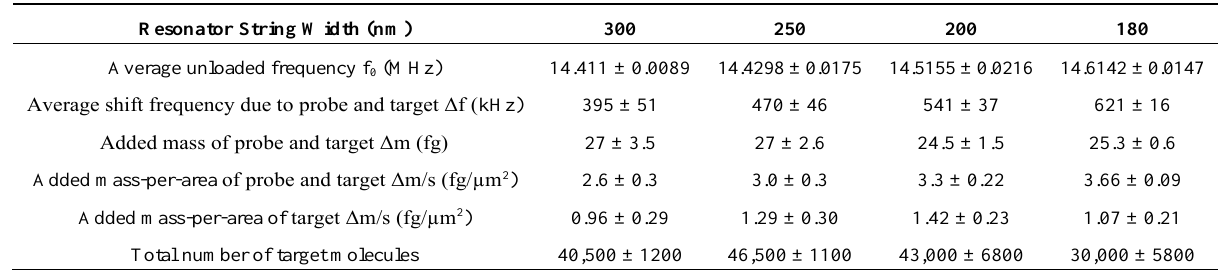
Table 2. Analysis of average resonant frequency shift and added mass of the resonator array of sample B due to the attachment of aryl film, anti-rabbit IgG, BSA and target rabbit